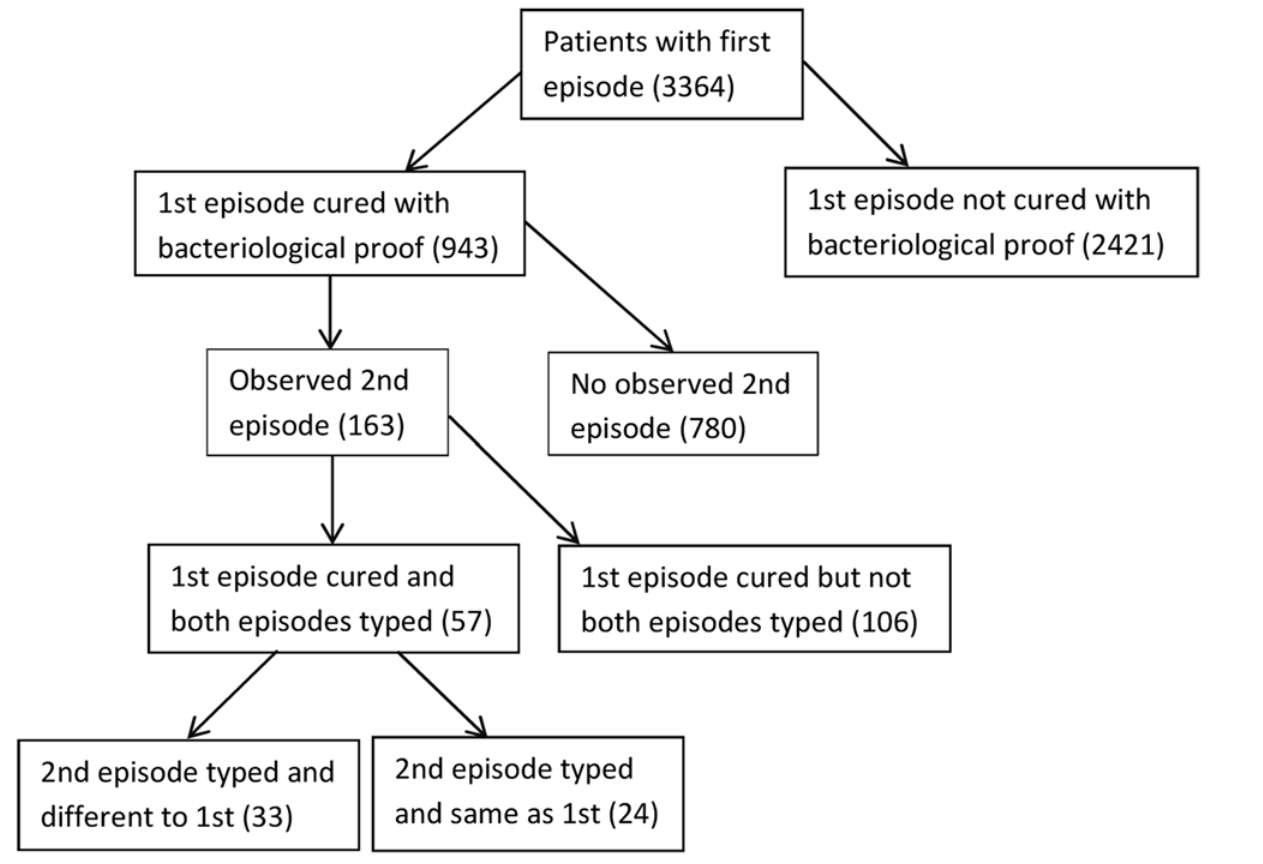
Fig 2. A schematic showing the breakdown of the 3364 patients with a documented first TB disease